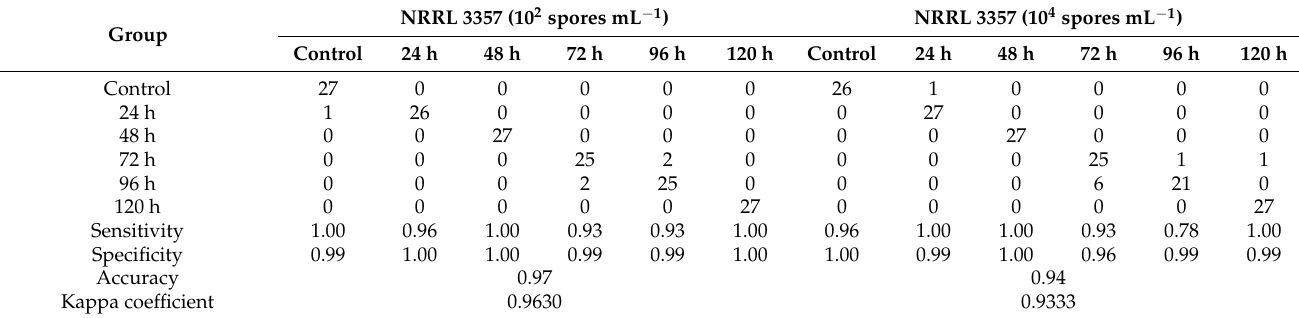
Table 2. Classification results of the confusion matrix.